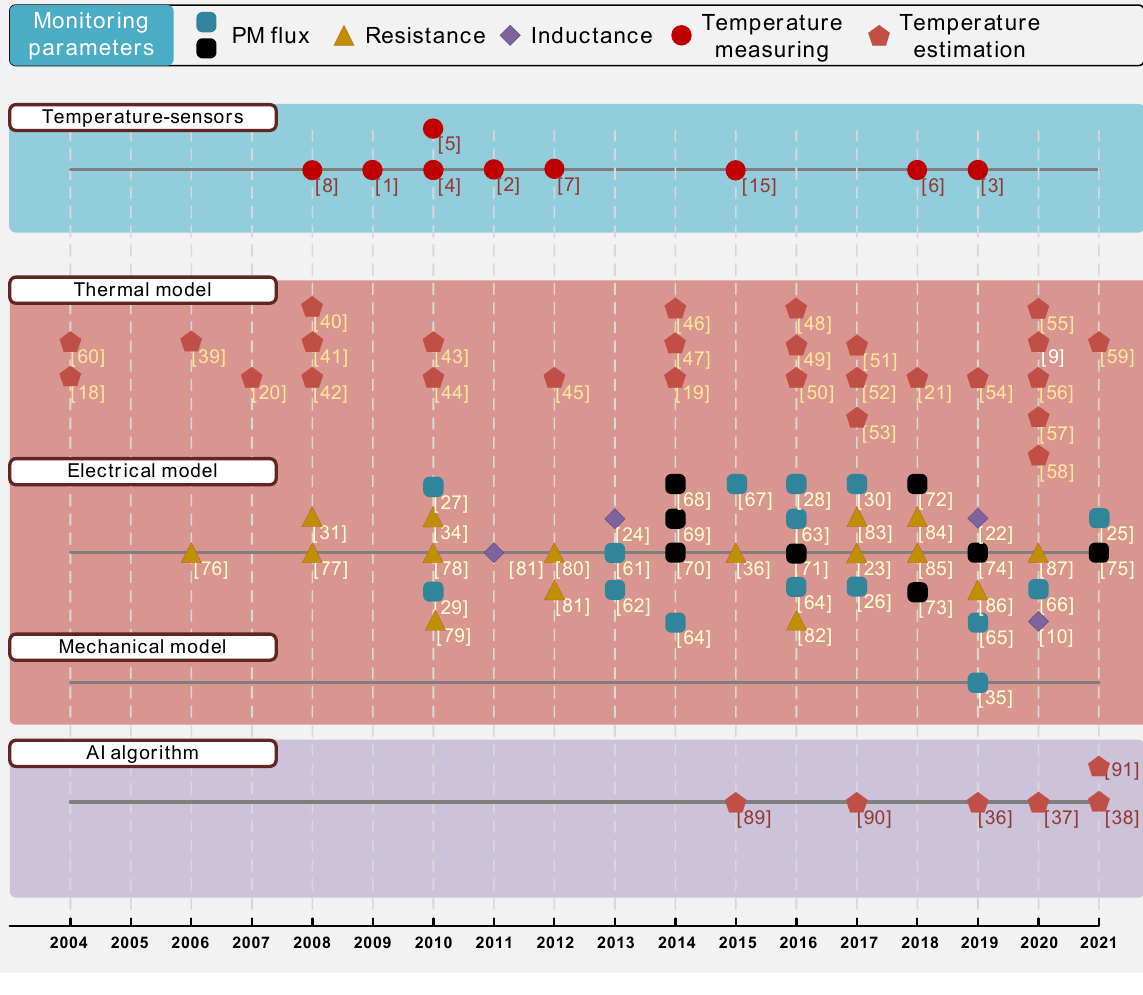
Figure 4. Development of the temperature monitoring methods for PM machines [1–10,15,18–31,34– 87,89–91].